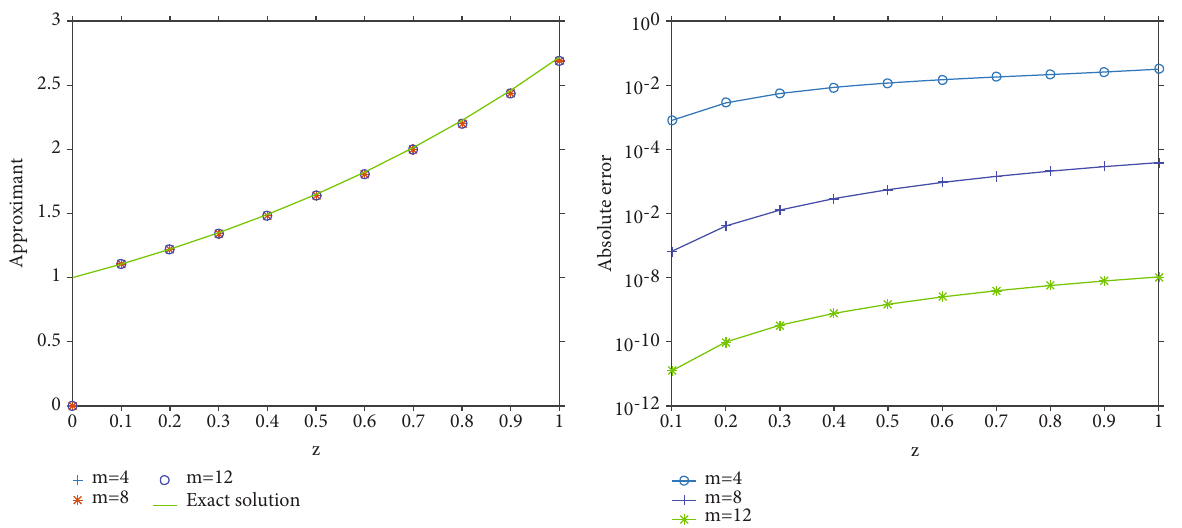
Figure 4: The approximate solution for Example 4 and its absolute errors at di ff erent values of m